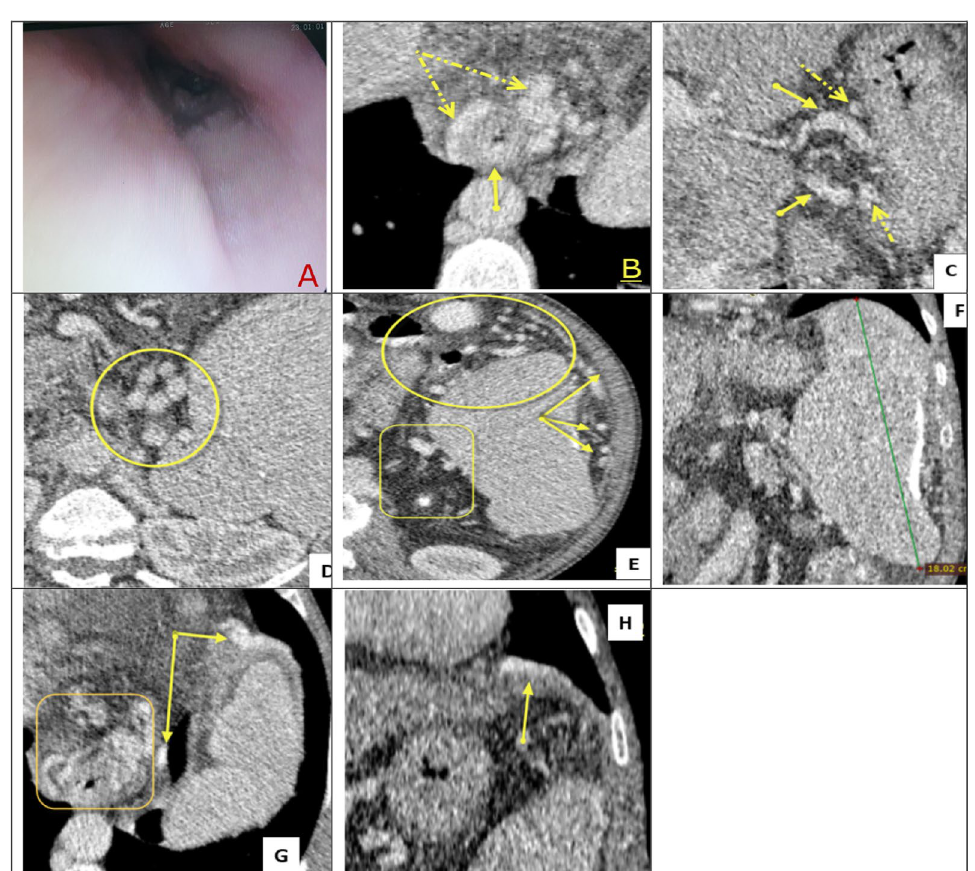
Fig. 3 A 66-year-old male patient complained of chronic liver disease complicated by esophageal varices on follow-up with upper GI endoscopy. A Upper GI endoscopy shows obliterated esophageal varices. Axial CT shows; B no esophageal (obliterated) varices (solid arrow) but large tortuous paraesophageal varices (dashed arrows), C dilated tortuous left gastric (coronary) varices (solid arrow) and perigastric (adventitial) varices (dashed arrow), D perisplenic (hilar) collaterals (round region), E perisplenic collaterals with anterior border (round region), lateral border (solid arrows), and hilar (rectangular region). Coronal CT shows; F enlarged LS diameter of the spleen 18 cm. G Axial CT shows left supradiaphragmatic varices (solid arrows) and paraesophageal varices (rectangular region). H Coronal CT shows left supradiaphragmatic varices (solid